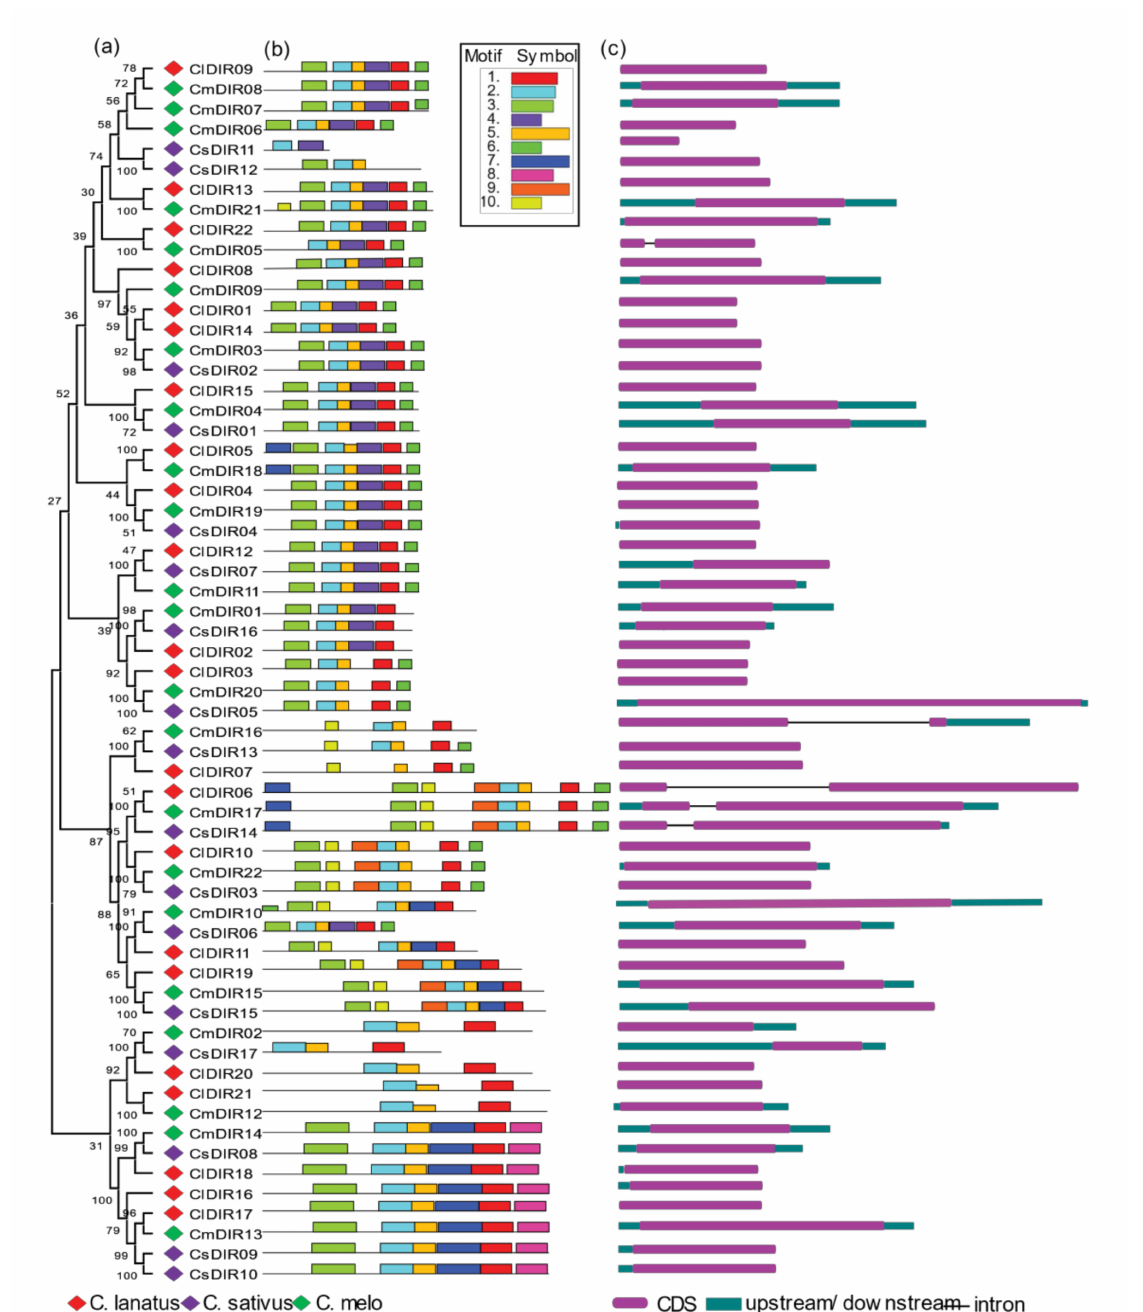
Figure 2. Phylogenetic tree, motif distributions and gene structure of the DIR proteins in different cucurbit species. ( a ) Phylogenetic tree, diamonds in different color represents different species. Red— Citrullus lanatus ; green— Cucumis melo ; purple— Cucumis sativus. ( b ) Conserved motif analysis of DIR proteins. Motifs were identified using MEME online tool and illustrated in different colors. ( c ) CDS and upstream/downstream structures of DIR